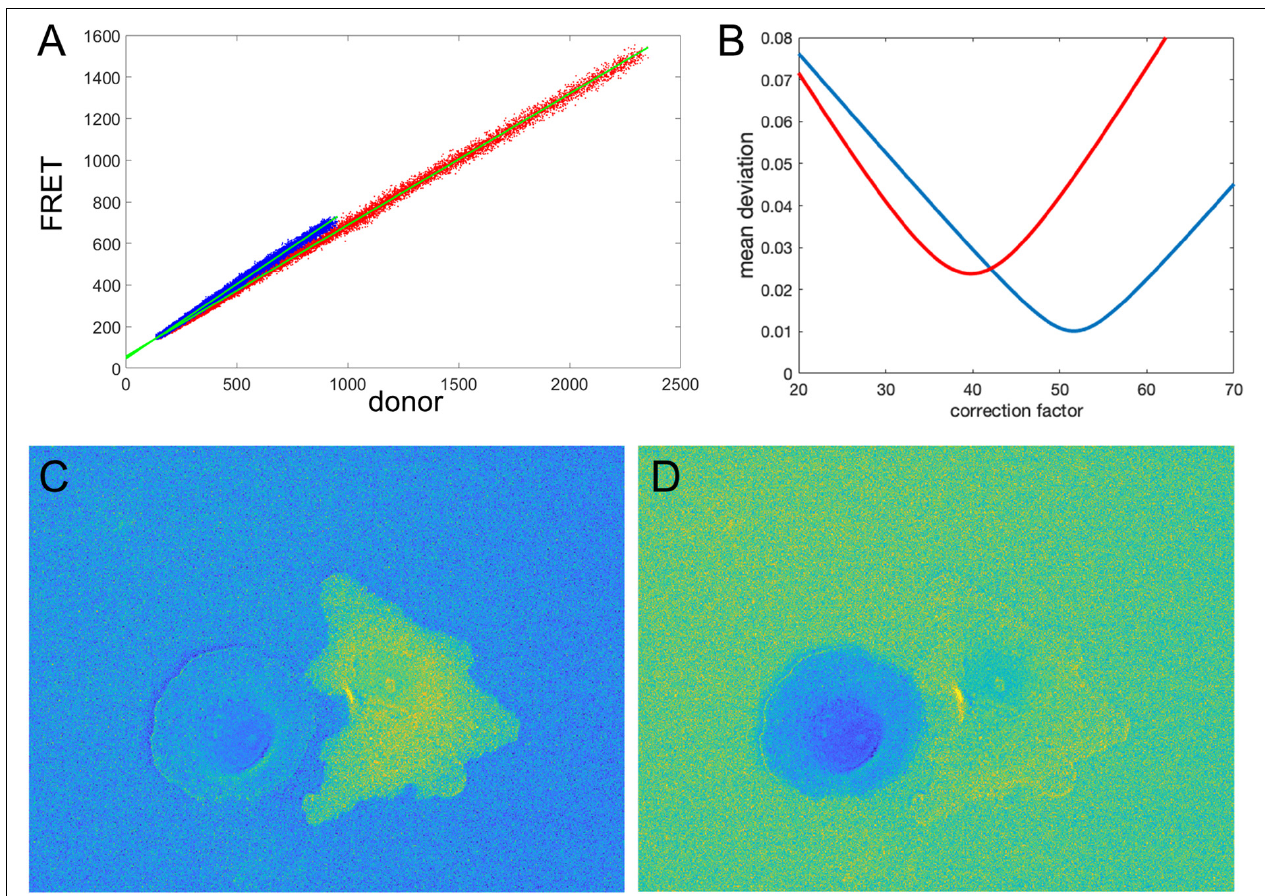
FIGURE 5 | Illustration of the correction factor method. (A) Intensity in the FRET vs. donor channels for each pixel. Red and blue colors indicate pixels in the left and right cells, respectively. The green lines indicate linear fits to the data points. (B) The deviation function (Equation 5) for a range of correction factor values. Red and blue curves are the functions calculated separately for the left and right cells in the image. The optimal correction factors are defined as the positions of the minima of these functions. (C,D) The ratio images resulted from the subtraction of the correction factors. In panel (C) , the signal in the left cell flattens with the background level as predicted by the mathematical analysis. Similarly, in panel (D) , the right cell flattens with the background. The flattening is so efficient that the noise fluctuations become